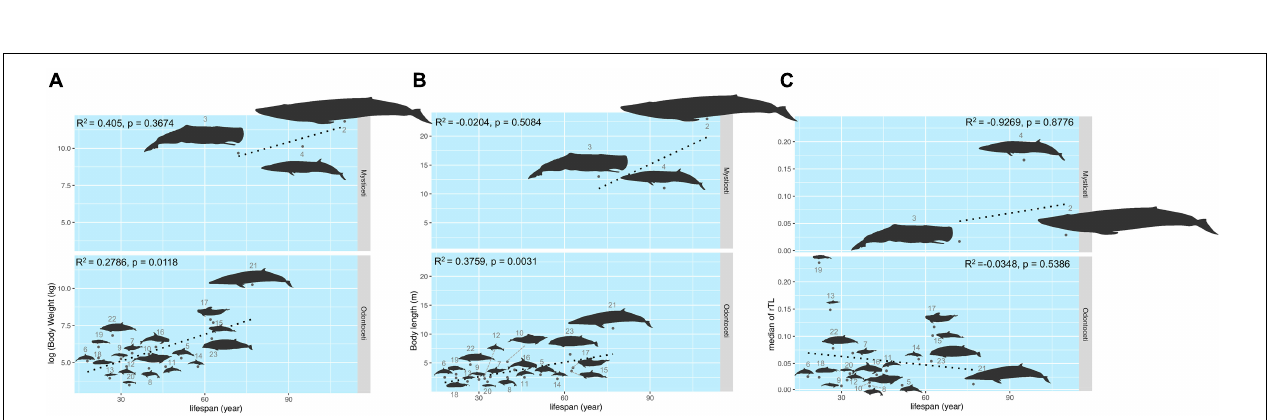
FIGURE 2 | Relationships of maximum lifespan with body weight (A) , body length (B) , and median relative telomere length (C) across marine mammal species found in Thailand oceans. The size of the figures illustrates accordance to the real ratio. The numbers represent species of marine mammals as depicted in Table 1 .